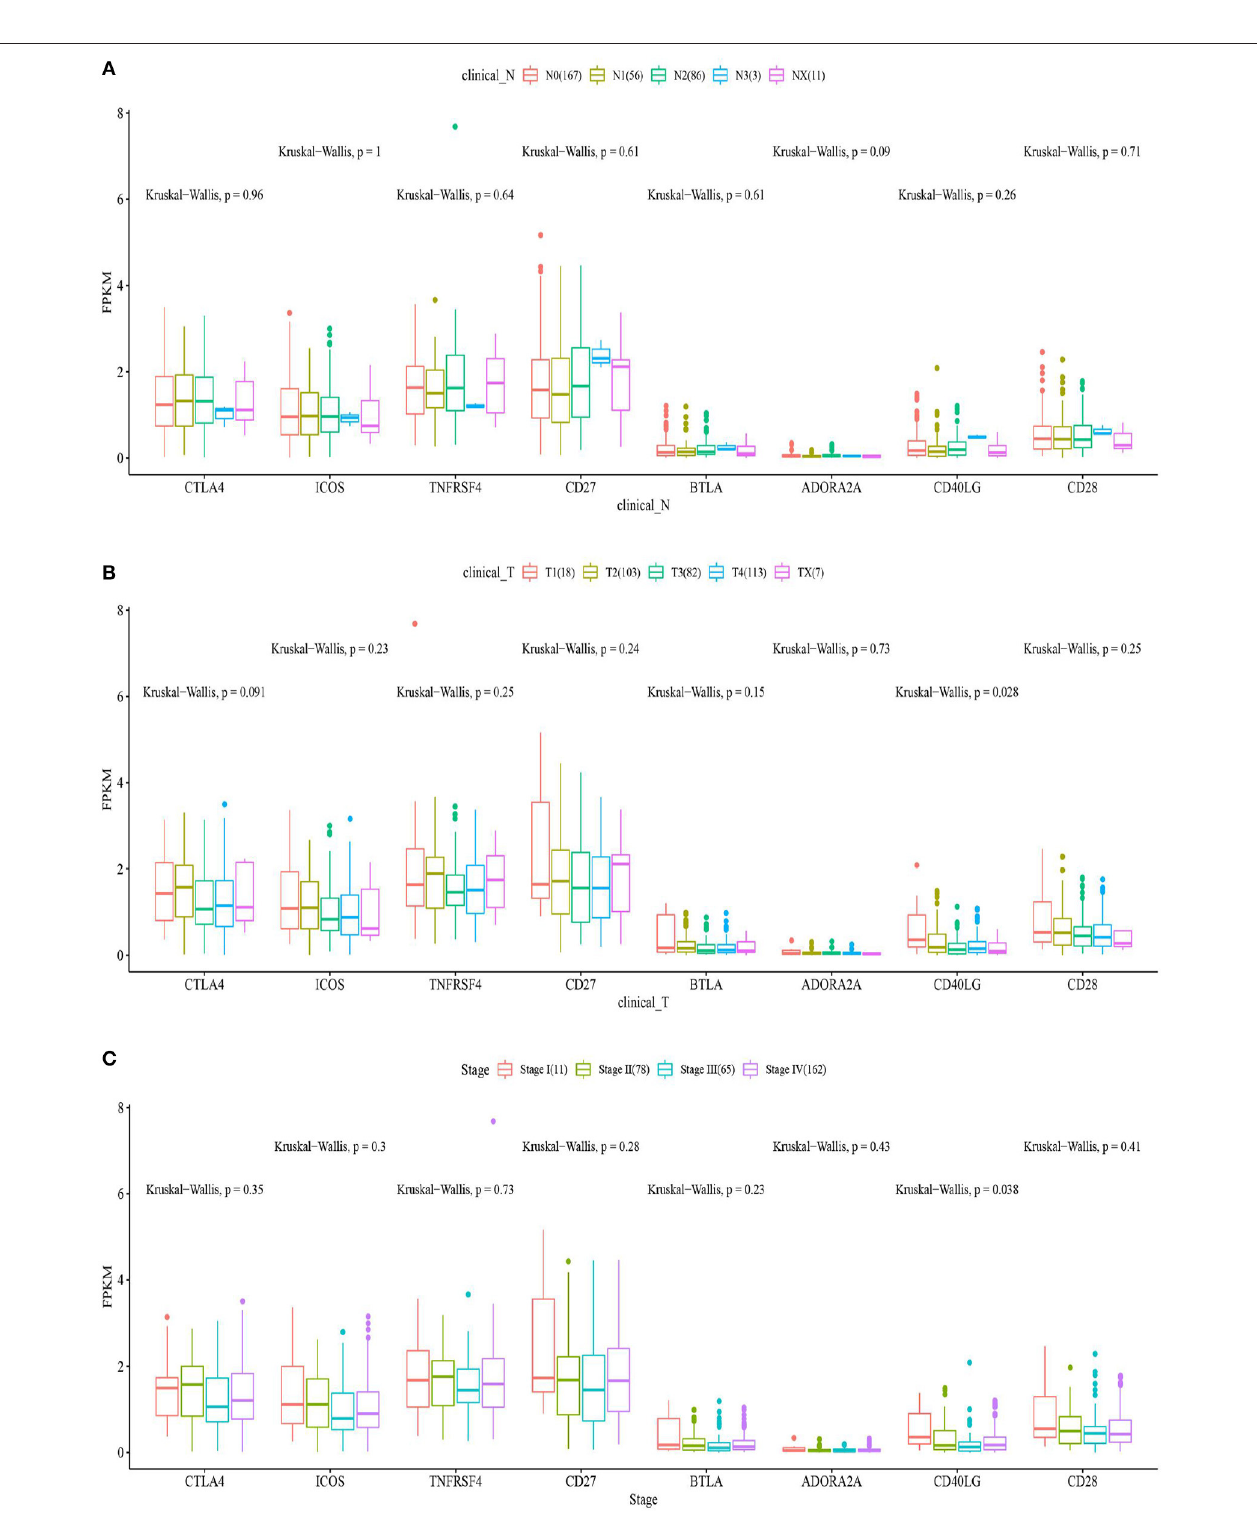
FIGURE 6 | The box plots show the eight ICGs positively correlated with CD274 and clinical features including N (A) , T (B) , and stages (C) .